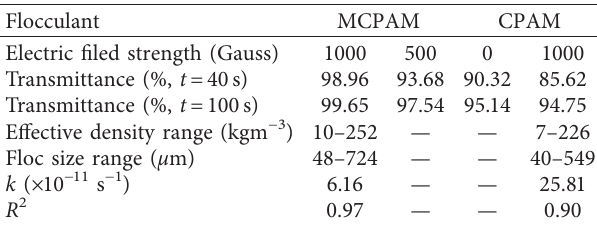
Figure 1: Changes of supernatant transmittance in the diatomite suspension treatment by the MCPAM and CPAM under different magnetic field strengths. Table 1: The flocculation rate constant for diatomite suspensions with various flocculants.